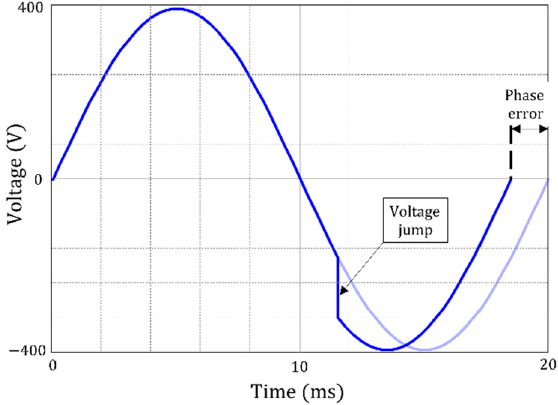
Figure 3. Example of voltage signal jump monitored in the voltage phase jump detection method.